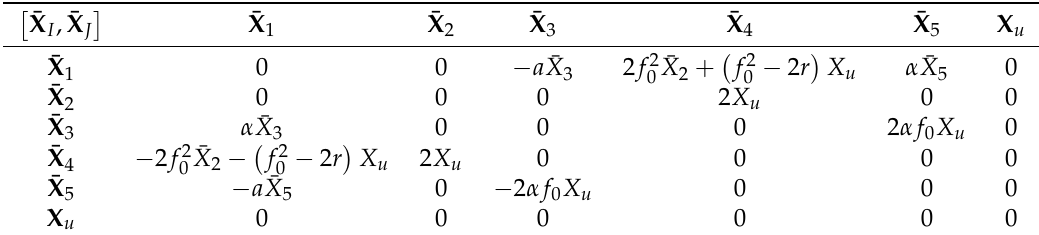
Table 1. Lie brackets of the Lie symmetries of Equation (10) for f ( y ) = f 0